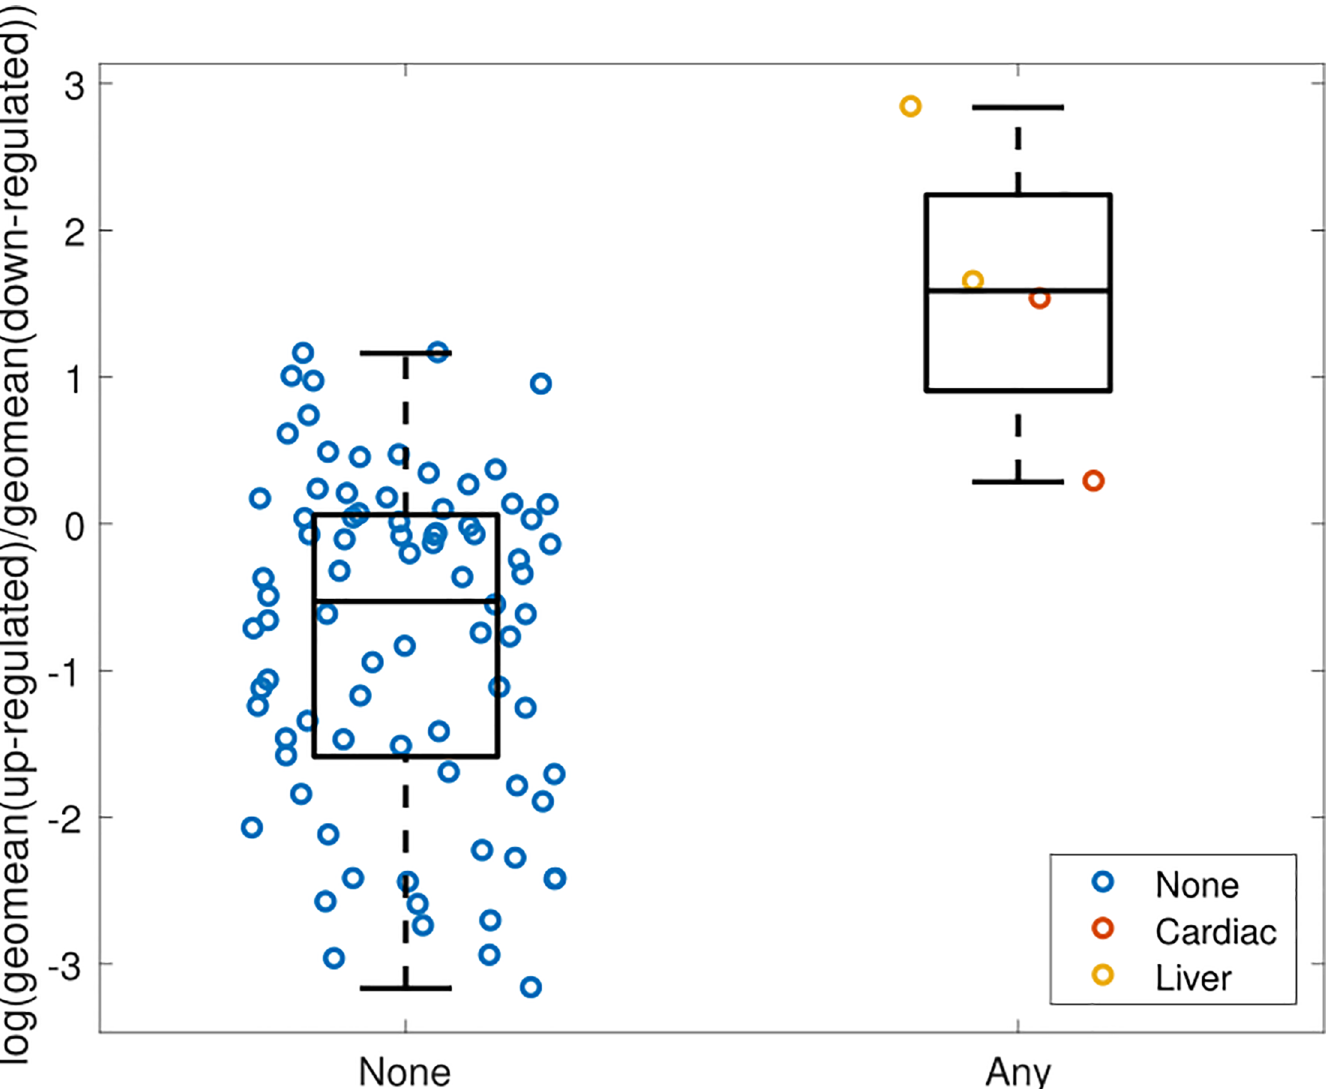
Fig 1. The 42 gene signature discriminates between NAFLD patients with and without clinical outcomes. The signature value (y-axis) is calculated as the geometric mean of upregulated probesets minus the geometric mean of downregulated probesets in log domain. Subjects (circles) are grouped by outcome (x-axis).